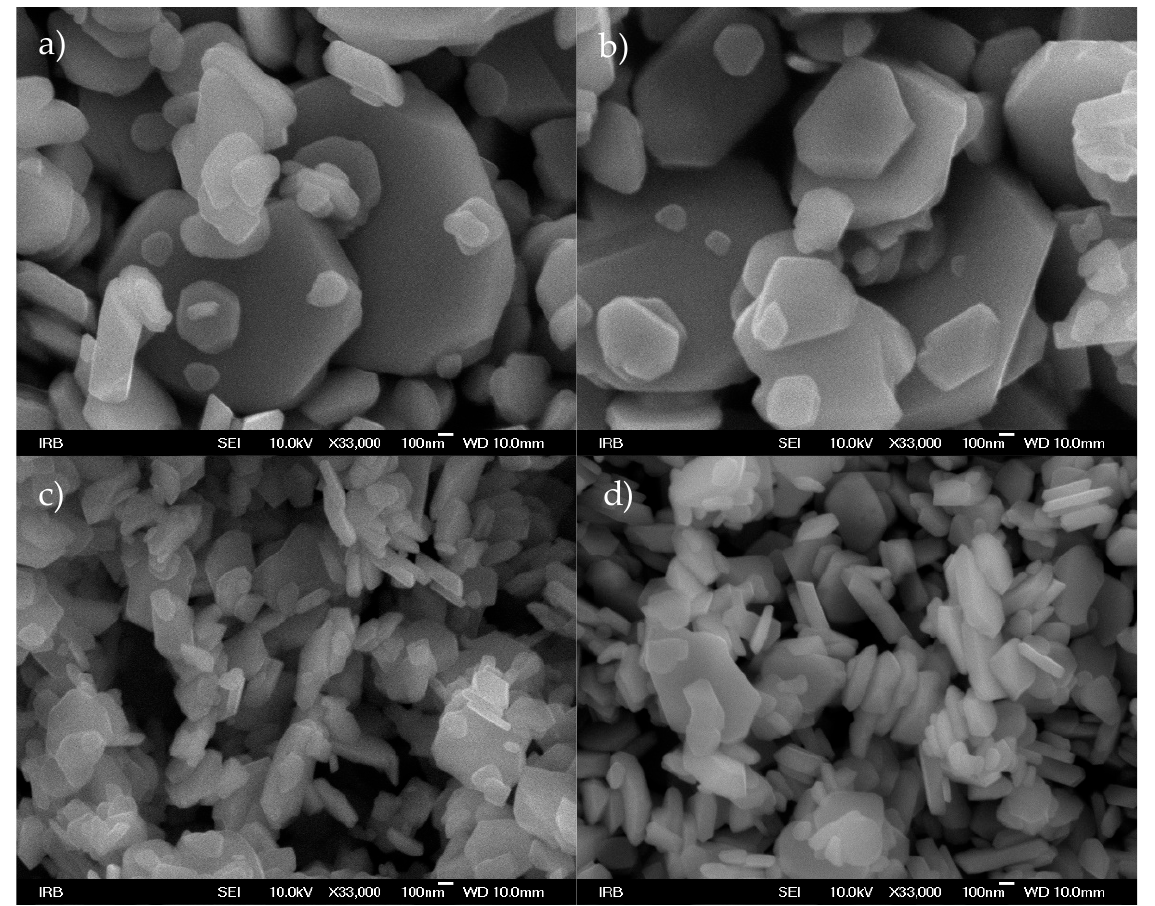
Figure 8. The FE - SEM images of ( a ) reference sample RS2 prepared for 20 min, ( b ) reference sample RS4 prepared for 5 min, ( c ) sample S13 with 1% PEG, and ( d ) sample S18 with 1% lavender essential oil, prepared at 260 °C for 5 min, taken at 33,000 × magnification .